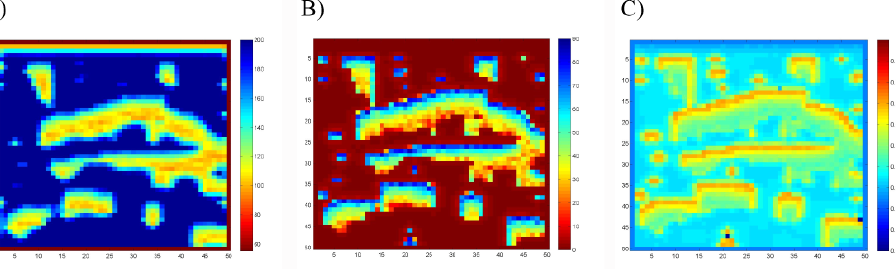
Fig. 5. (A) Ratio between the effective amount of water received and annual precipitation for the simulated pattern in Fig. 4g. (B) Long-term groundwater runoff on the study domain for the simulated pattern in Fig. 4g. (C) Long-term soil moisture content during the rainy season on the study domain for the simulated pattern in Fig.